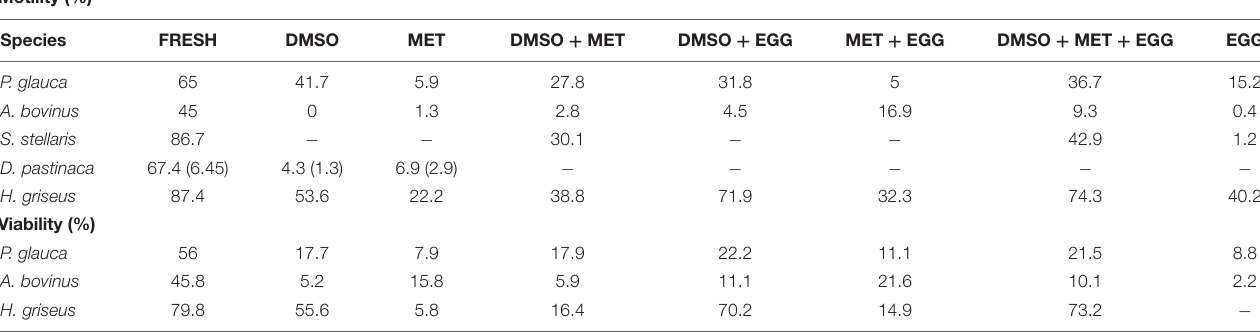
TABLE 3 | Results for non-model